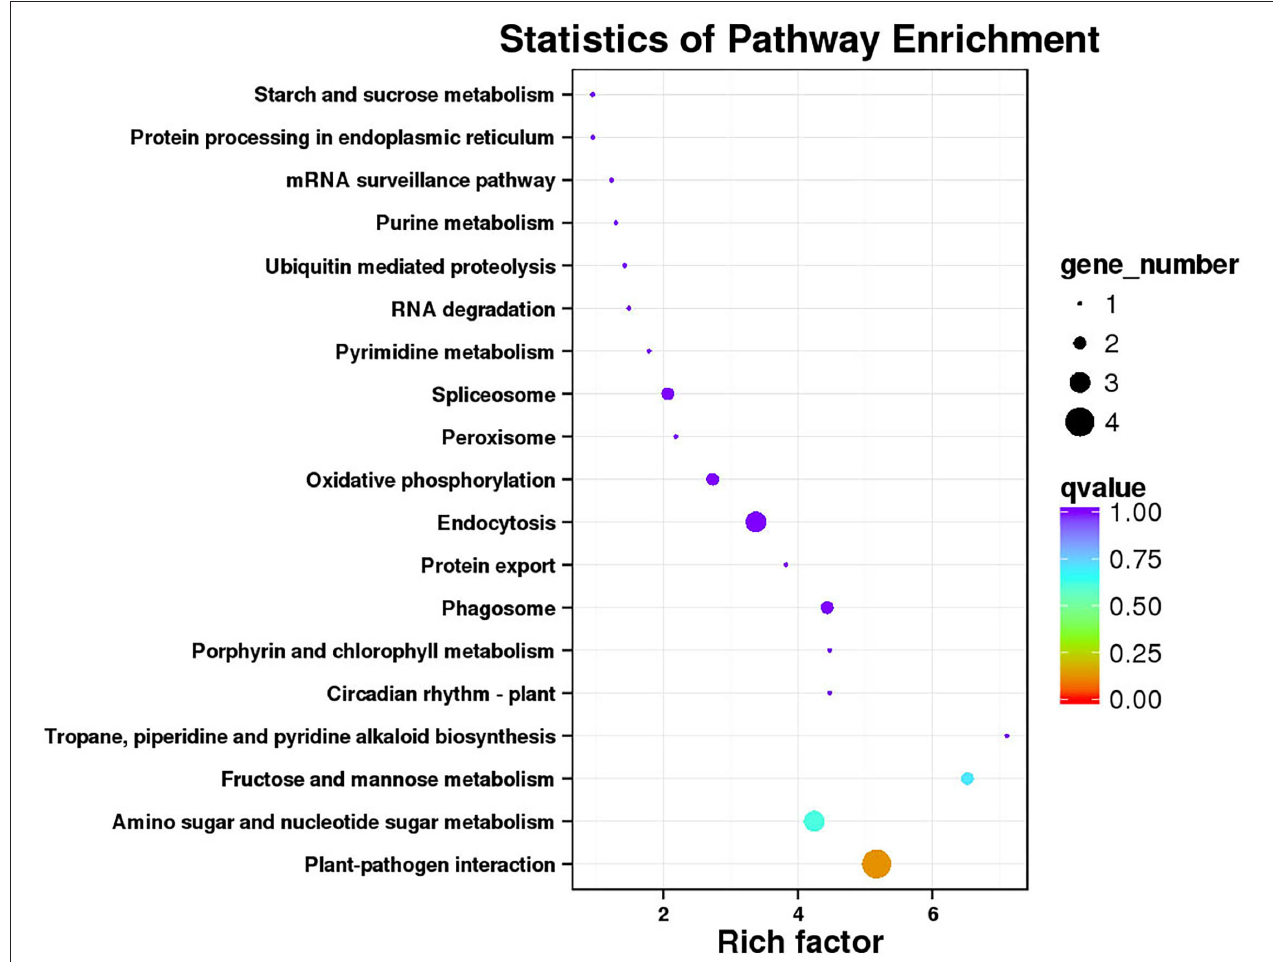
FIGURE 10 | Functional annotation and KEGG pathway enrichment of hub genes in